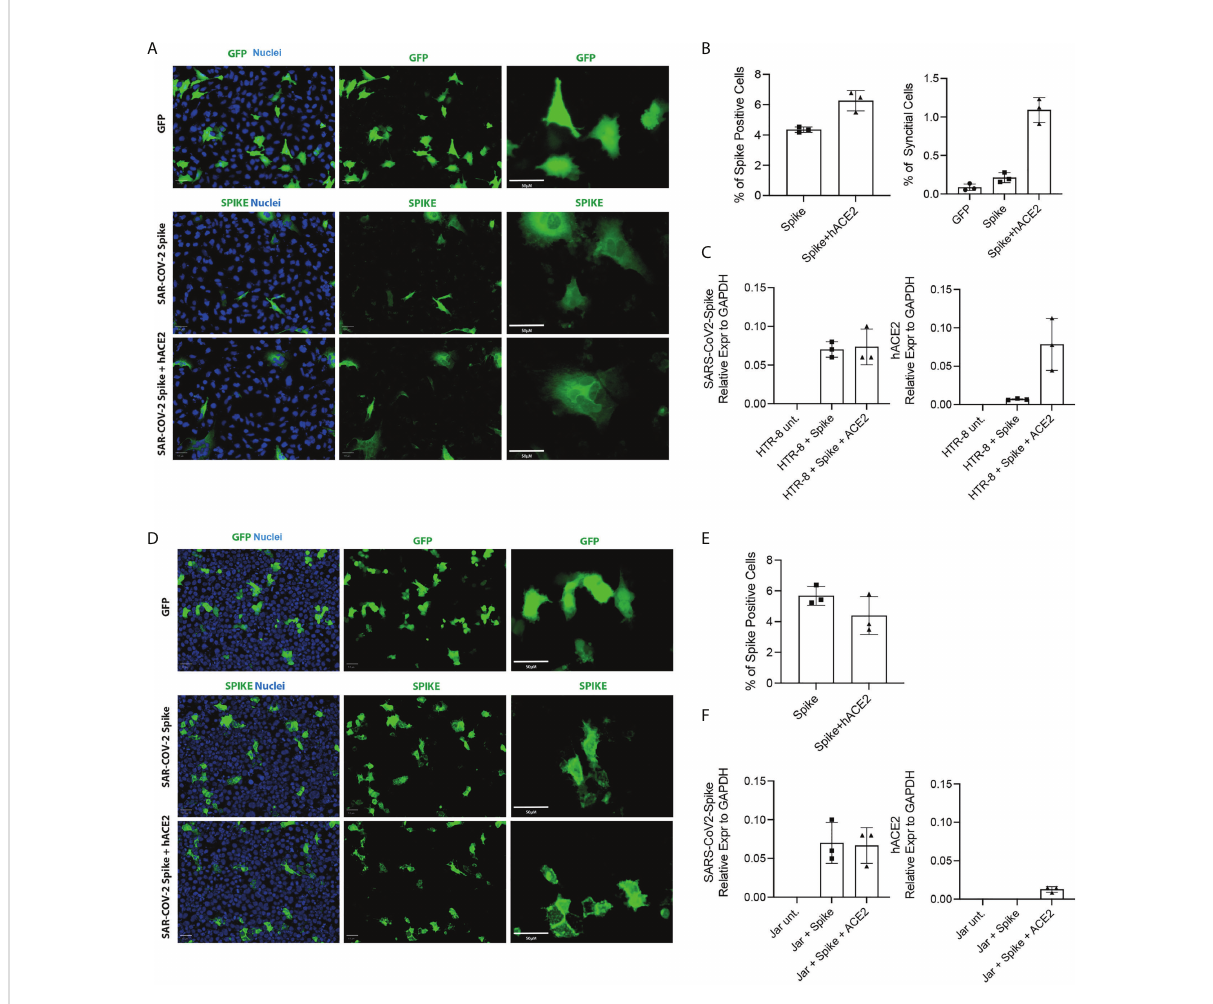
FIGURE 8 Cell Fusion Assay. HTR8/SVneo and JAR cells were seeded 10h before transfection. Cells were then transfected with pCMV-SPIKEDelta-V5 +pCMV-hACE2, pCMV-SPIKEDelta-V5+pcDNA3 or pCMV-GFP+pcDNA3. Representative images of green fl uorescence protein (GFP) and immunostaining for SARS-CoV-2 -Spike in HTR8 (A) and JAR (D) taken using the Operetta high content screening microscope (PerkinElmer) with Olympus 20 x (NA-0.45) objective. Quanti fi cation of the total cells expressing Spike and the total number of syncytia per well in HTR8 (B) and JAR (E) . mRNA expression levels by RT-qPCR of SARS-CoV2-Spike and hACE2 in HTR8 (C) and JAR (F)